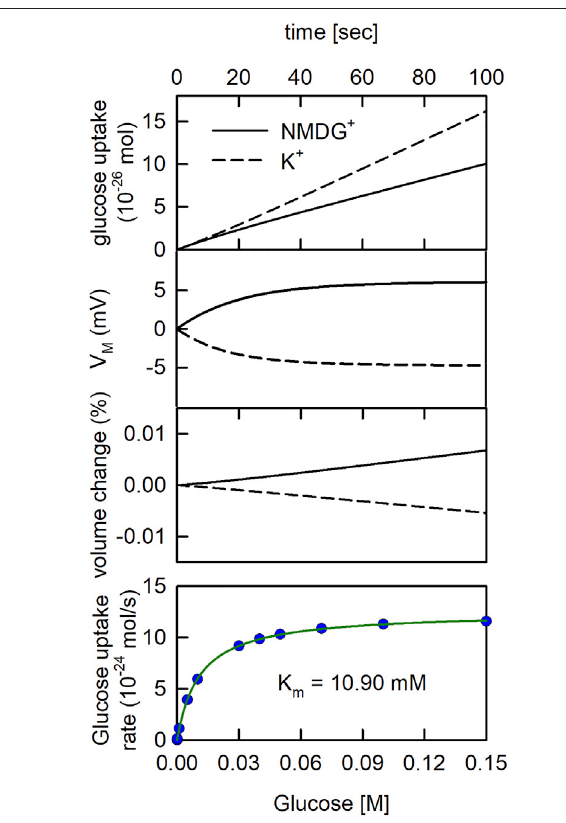
FIGURE 4 | The glucose uptake rate of SGLT1 is larger in the presence than inthe absenceofaK + gradient. Upper. Glucose uptakeby SGLT1.In the simulation 1 µM glucose was applied to the extraluminal side of the vesicle. In the in-silico experiment, we assumed that on average 4.3 monomers were inserted into the vesicle with half of them oriented outside-in (Erokhova et al., 2016). The extraluminal concentration of 200 mM NaCl was osmotically balanced with either 200 mM KCl or 200 mM NMDG + Cl − in the vesicle lumen. The rate of glucose uptake was higher in the presence of a K + gradient (dashedline)thaninitsabsence(solidline).UppermiddlepanelTimecourseof V M change. V M was more negative in the presence of the K + gradient (dashed line) than in its absence (solid line). Lower middle panel Time course of vesicle volume change. The volume of the vesicle slightly increased and decreased when 200 mM NMDG + (solid line) and 200 mM K + (dashed line) were initially contained in the vesicle, respectively. Lower panel Simulated glucose uptake as a function of glucose concentration (blue dots). The synthetic data were fi t to the Michaelis Menten equation (green curve): Glu cos euptakerate (cid:2) ( V max · [ S ]) / ( K m + [ S ]) . The K m − and the V max value estimated by the fi t were 10.90 mM and V max of 1.22 ± 0.006 · 10 − 23 mol/s (simulation conditions: 150 mM NaCl, 20 mM MOPS, and pH 7.5 with 4.3 hSGLT1 ’ s per vesicle), respectively.